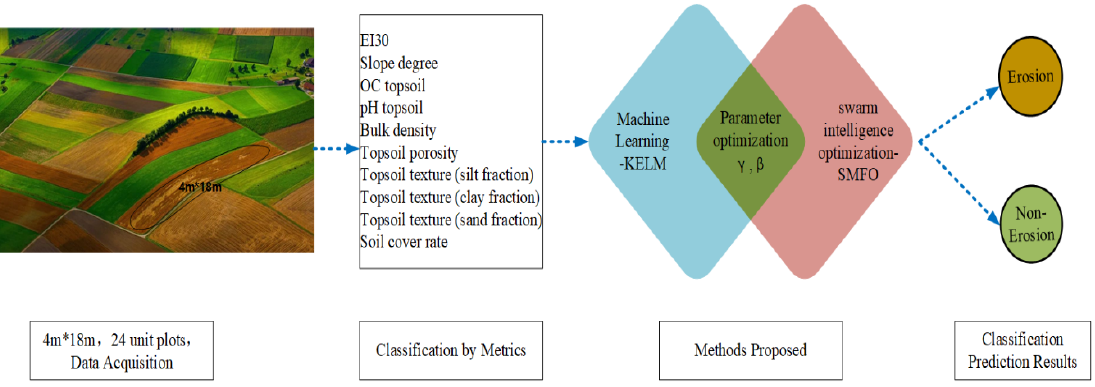
Figure 1. The framework of this paper.